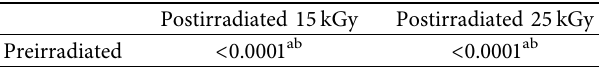
Table 2: Comparison of TGF- β levels in amnion sponge before and after radiation sterilization.